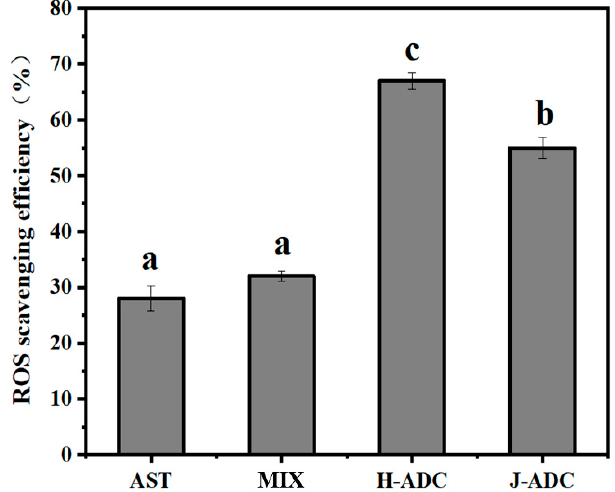
Figure 4. The ROS scavenging efficiency of different antioxidants in Caco-2 cells ( n = 6). a–c Different letters show statistically significant differences ( p < 0.05) between different groups, whereas bars labelled with the same letter correspond to results that show no statistically significant differences.